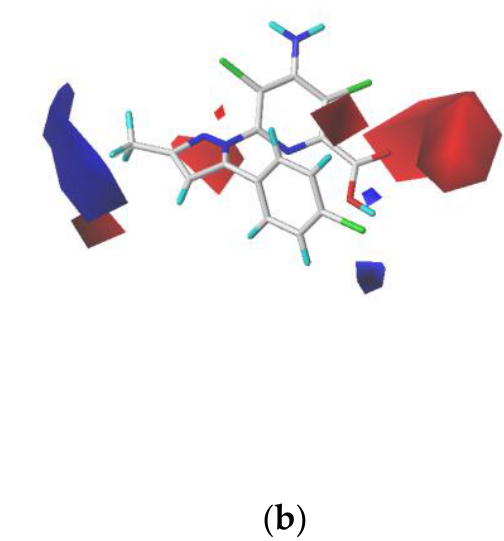
Figure 8. Contour maps of CoMFA analysis with the most active compound V-7 . In each field, favored and disfavored areas are fixed at 80 and 20% contribution levels, respectively; ( a ) steric field: green contours represent the favored regions whereas yellow contours represent the disfavored regions; ( b ) electrostatic field: blue contours represent the favored regions whereas red contours represent the disfavored regions.